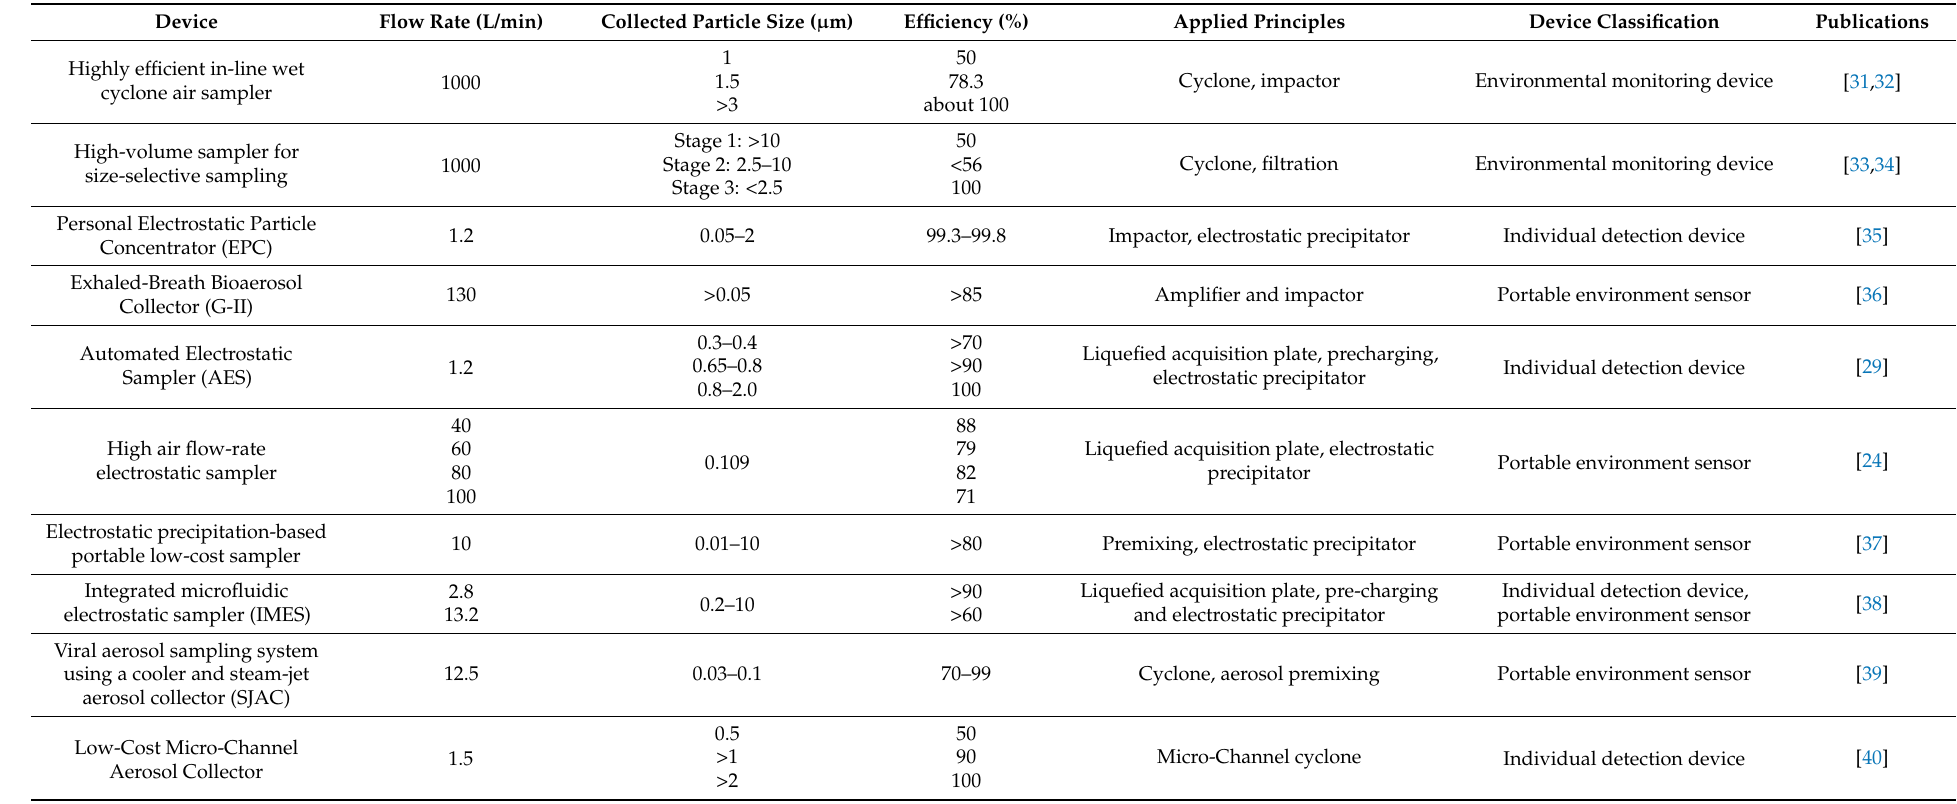
Table 1. Comparisons on the Comprehensive Devices of Airborne Virus